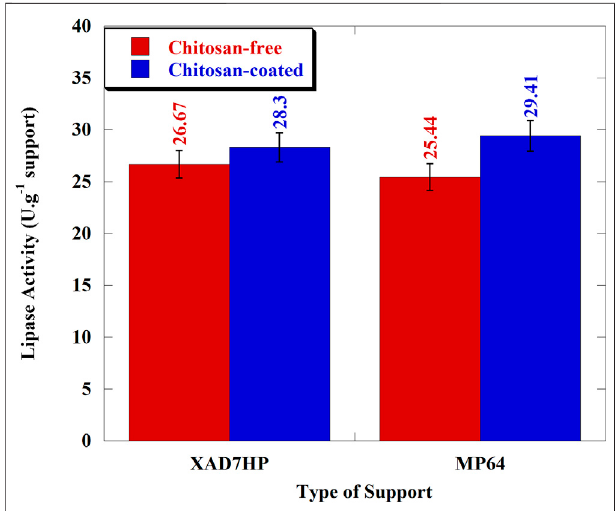
FIGURE 5 | Lipase activity of immobilized Aspergillus niger lipase on